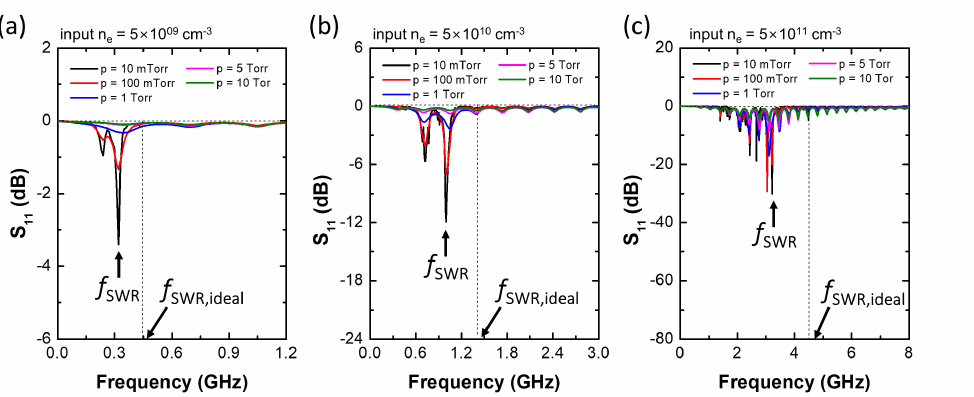
Figure 3. S 11 spectra with various pressures ( p ) at a constant sheath width of 0.234 mm and electron